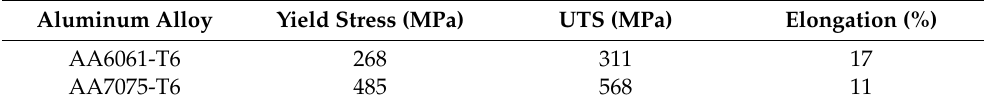
Table 3. Mechanical properties of AA6061-T6 and AA7075-T6 Aluminum alloys [36].